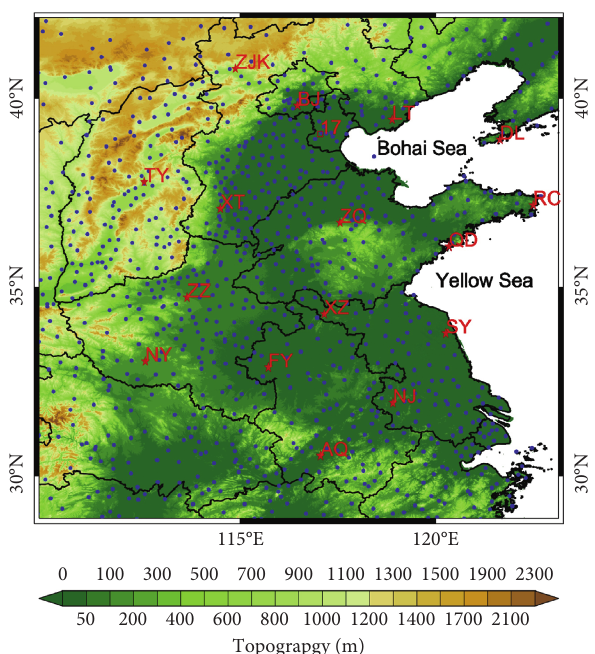
Figure 1: Altitude and stations distribution in the study area (blue dots are national meteorological stations in the study area, red five- pointed stars are the distribution of sounding stations, and the red square is the location of Tianjin Meteorological